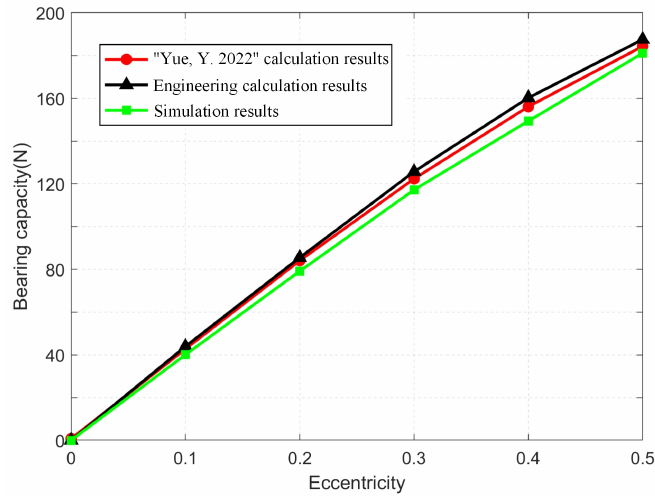
Figure 5. Relationship between bearing capacity and eccentricity [29].